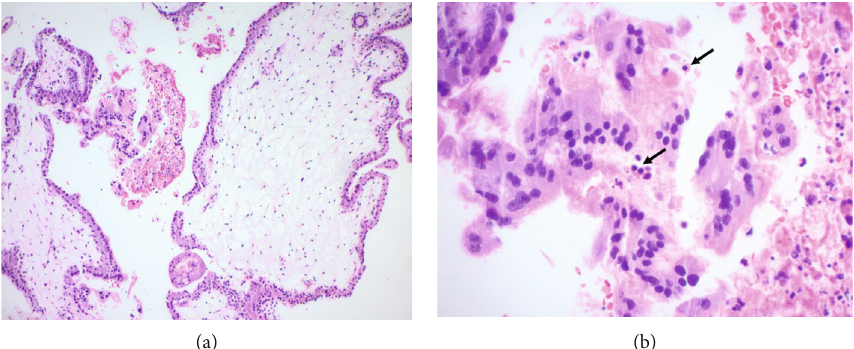
Figure 2: (a) Low power image of a partial mole shows an admixture of normal-appearing and enlarged hydropic villi scalloped borders. (b) High power image shows nucleated red blood cells (arrow) ((a) original magni fi cation × 100; (b) original magni fi cation × 400, hematoxylin and eosin (H&E)